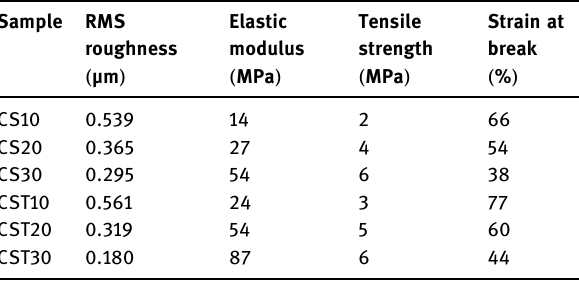
Table 3: RMS roughness and mechanical properties of the nano - fi ber mats with and without T80 addition